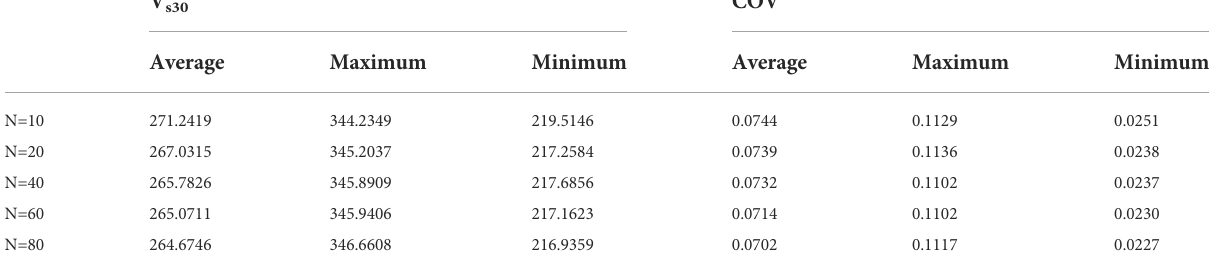
TABLE 2 Variability of V s30 realizations under different N